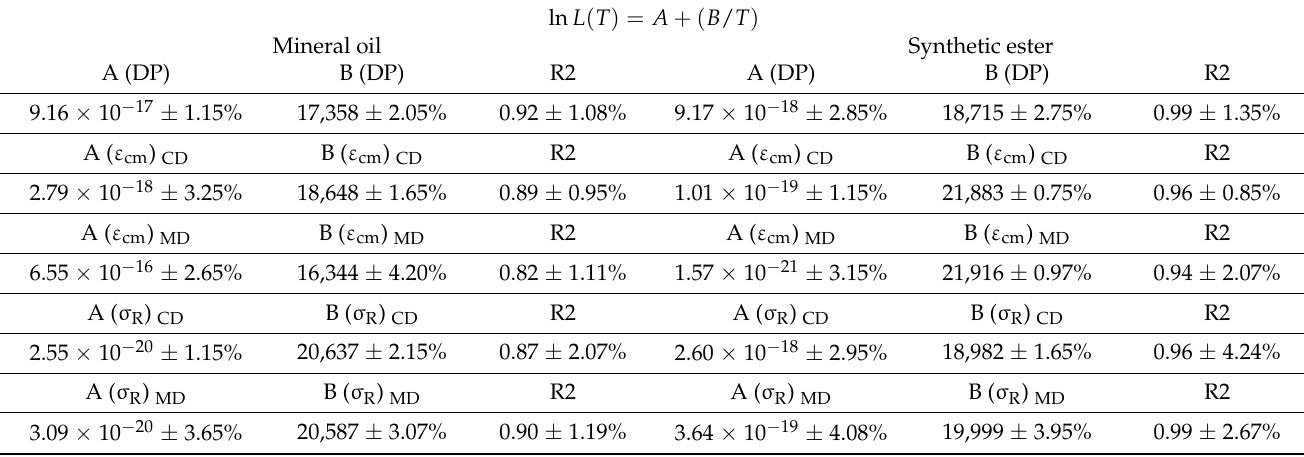
Table 9. Constants for the IEEE model based on lifetime needed to reach end-of-life criteria (DP = 350, ε cm = 0.5 ∗ ε cm0 , σ R = 0.5 ∗ σ R0 ) for different insulation